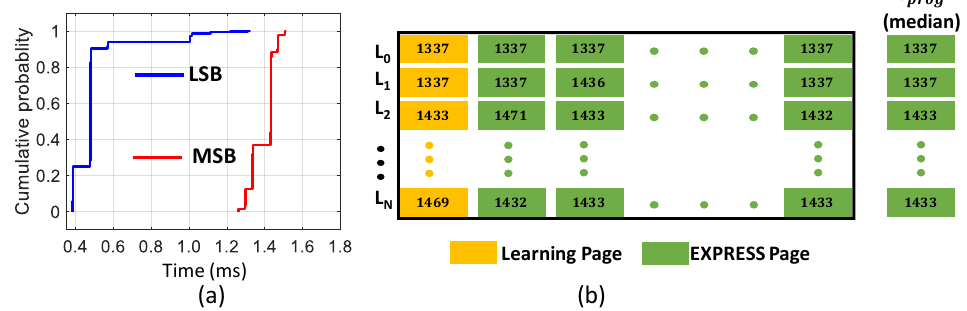
Figure 11. ( a ) Cumulative distribution of program times for LSB (blue) and MSB (red) pages in a block in fresh condition; ( b ) Express algorithm for MSB pages. The numbers represent the nominal 𝑡 𝑝𝑟𝑜𝑔 values in 𝜇𝑠 corresponding to the page location.